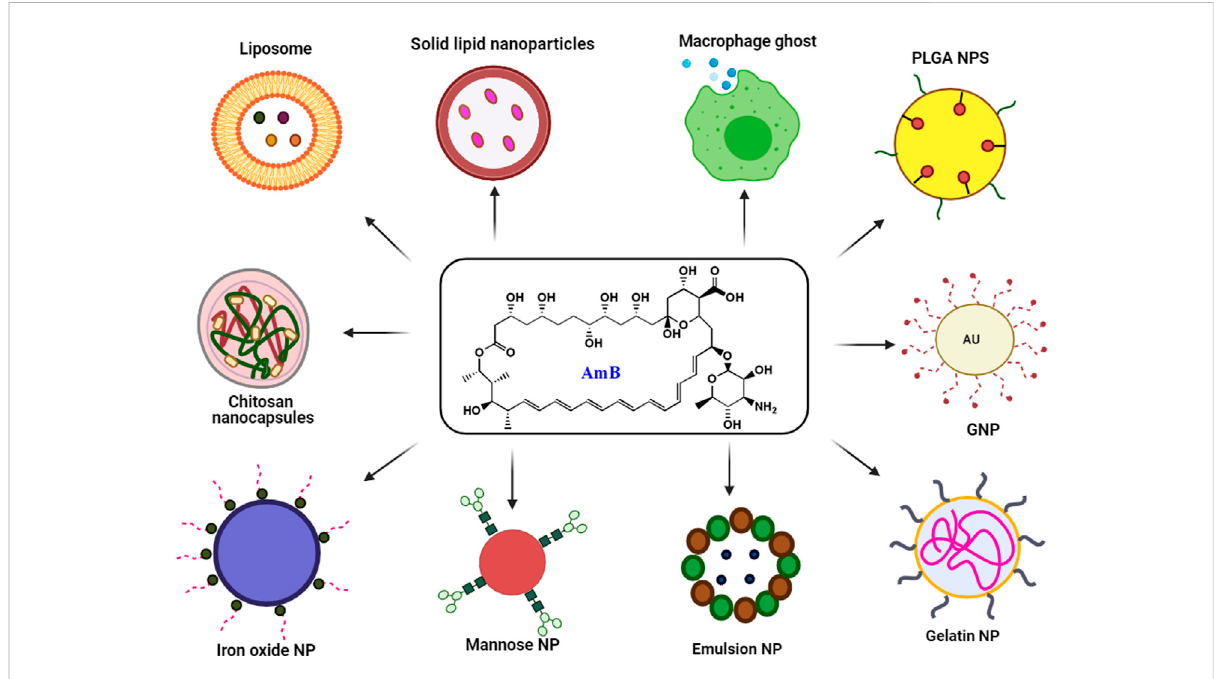
FIGURE 3 Schematic presentation of major nano formulation based delivery of